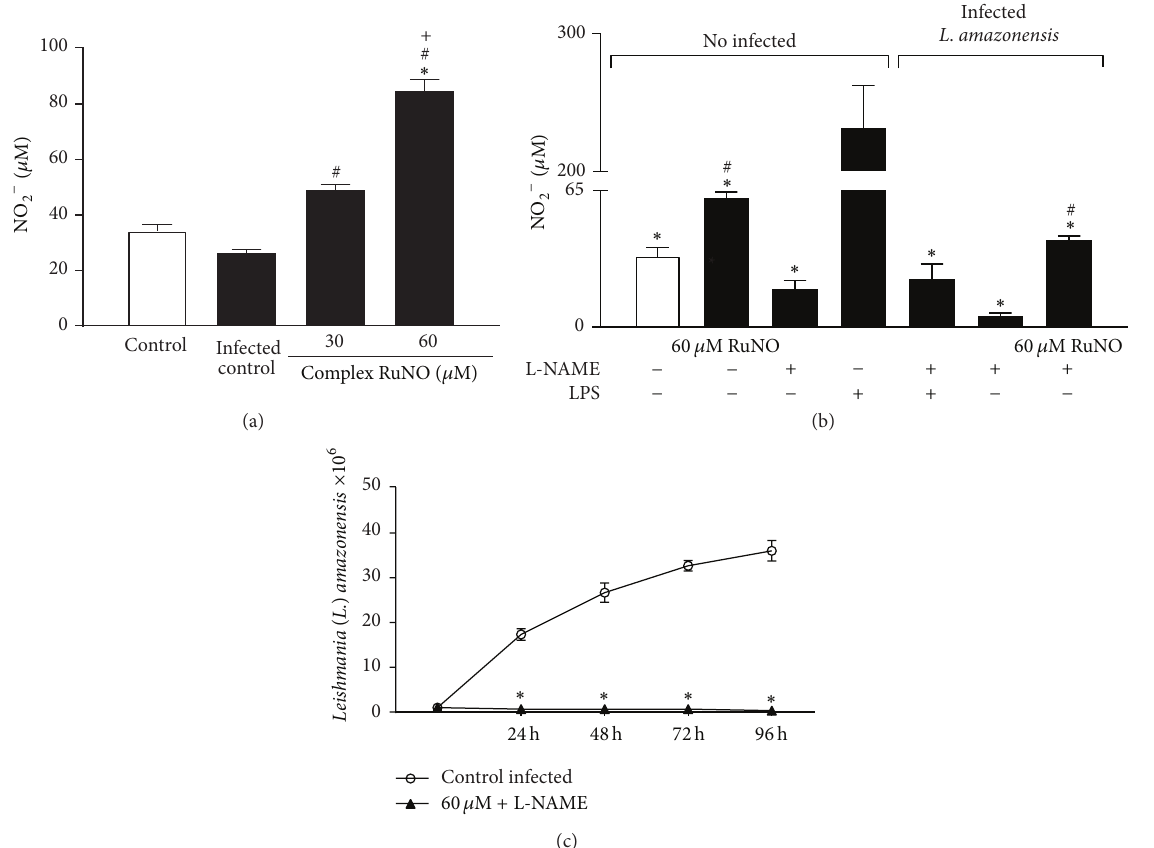
Figure 3: (a) Nitrite levels of macrophages infected and then treated with RuNO complex (30 and 60 𝜇 M) for 24h [ ∗ significantly different from control, # significantly different from infected control, and + significantly different from concentrations]. (b) Determination of nitrite levelsofperitonealmacrophagesstimulatedwithLPS,infectedwith L. amazonensis ,andthentreatedwith100 𝜇 ML-NAMEand60 𝜇 MRuNO complex for 24 h. [Values represent the mean ± SEM of three independent experiments ( 𝑃 < 0.05 ). ∗ significantly different from control LPS and # significantly different from infected control with L-NAME]. (c) Recovery kinetics of promastigotes in peritoneal macrophages infected with L. amazonensis , treated with RuNO complex (60 𝜇 M) and the iNOS inhibitor L-NAME (100 𝜇 M) for 24 h. [ ∗ significantly different from infected control at all